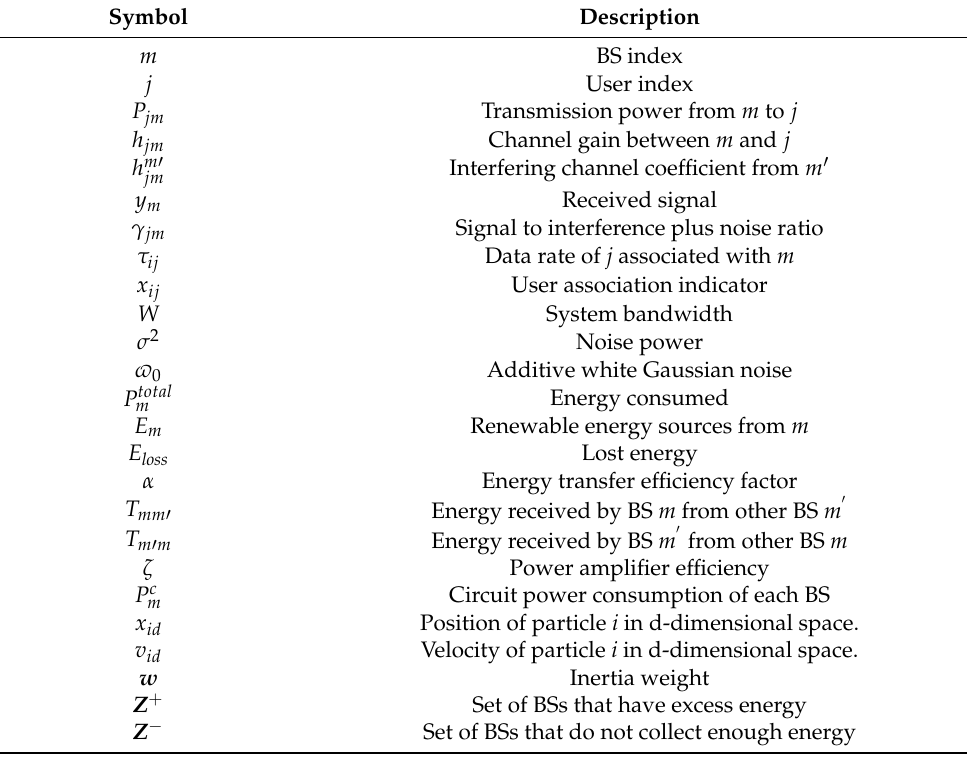
Table 1. List of symbols list with